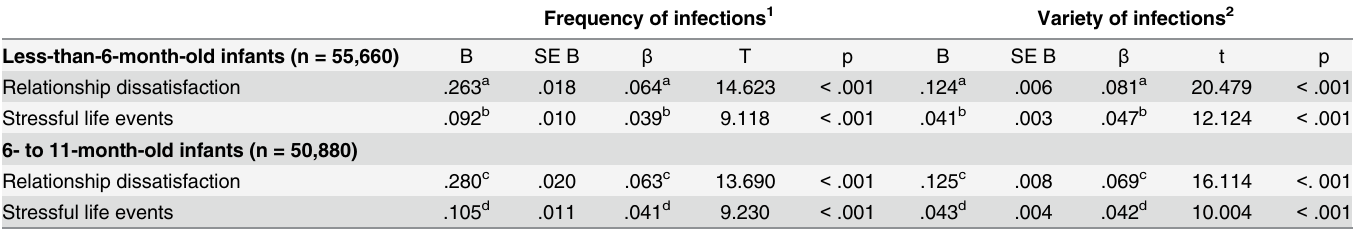
Table 3. Unstandardised and standardised regression coefficients for relationship dissatisfaction and stressful life events in pregnancy on num- ber of infectious diseases in the